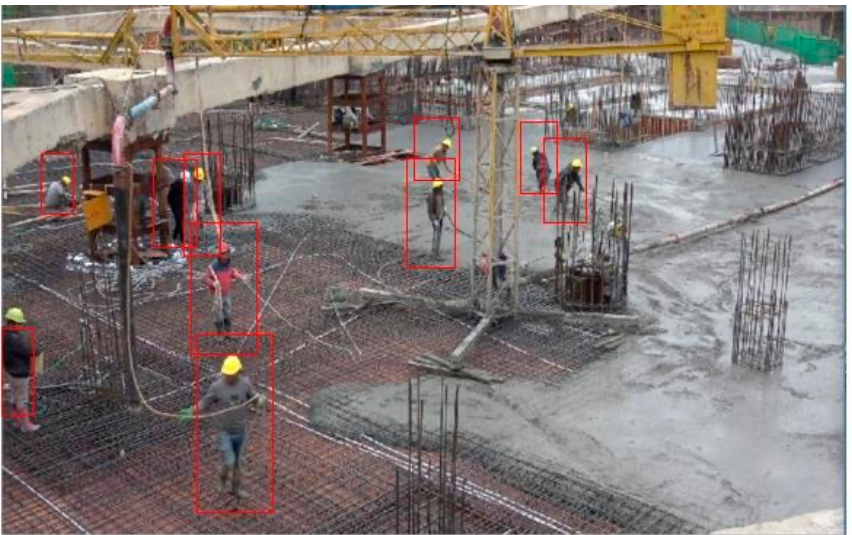
Figure 13. Worker detection.